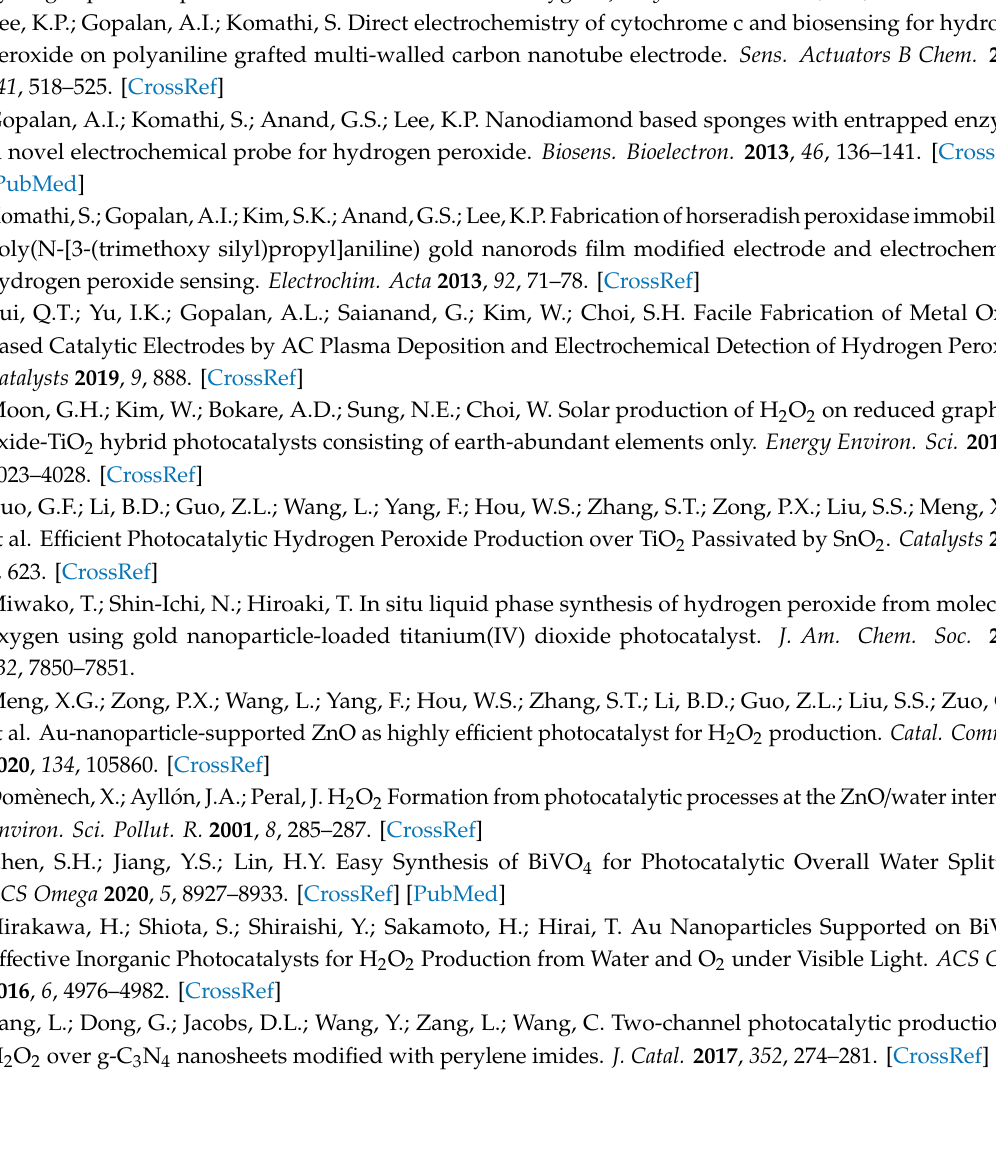
Table S1: Inductively coupled plasma mass spectrometry (ICP-MS) test results of Au / β -CD-CN with di ff erent Au content, Figure S1: Standard curve: a linear relationship for the optical absorbance at 454 nm as a function of H 2 O 2